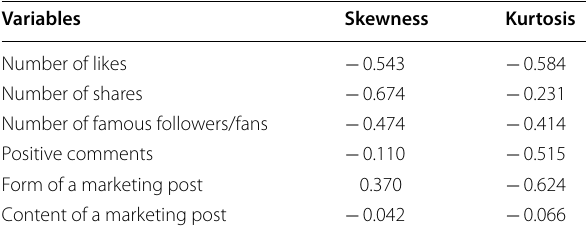
Table 4 Skewness and kurtosis values for the evaluation of normal distribution